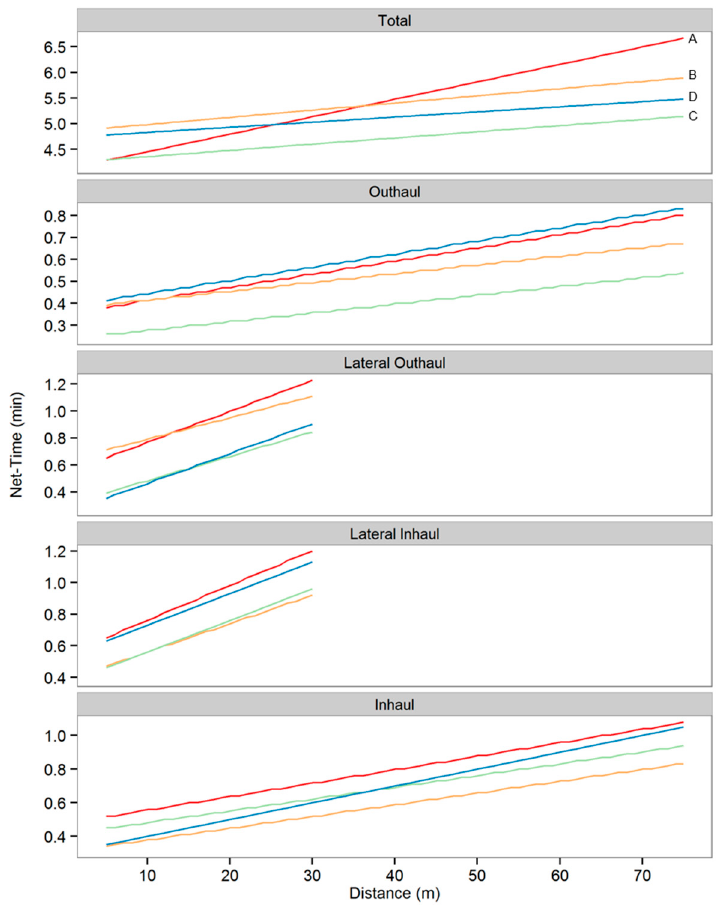
Figure 5. Standardized time demand for the total yarding cycle (Total) vs. yarding distance for campaign ( A ) red , ( B ) orange , ( C ) green and ( D ) blue and corresponding time demand for the cycle elements Outhaul (vs. yarding distance), Lateral Outhaul (vs. lateral distance), Lateral Inhaul (vs. lateral distance) and Inhaul (vs. yarding distance) .